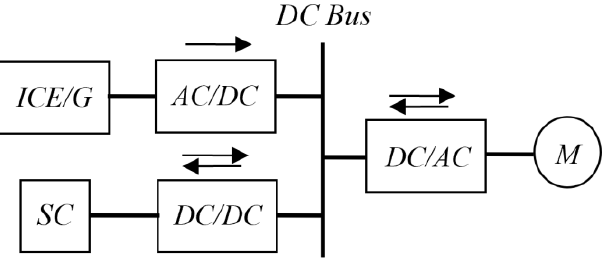
Figure 4. Combined truck drive system with ICE/G as main power source.